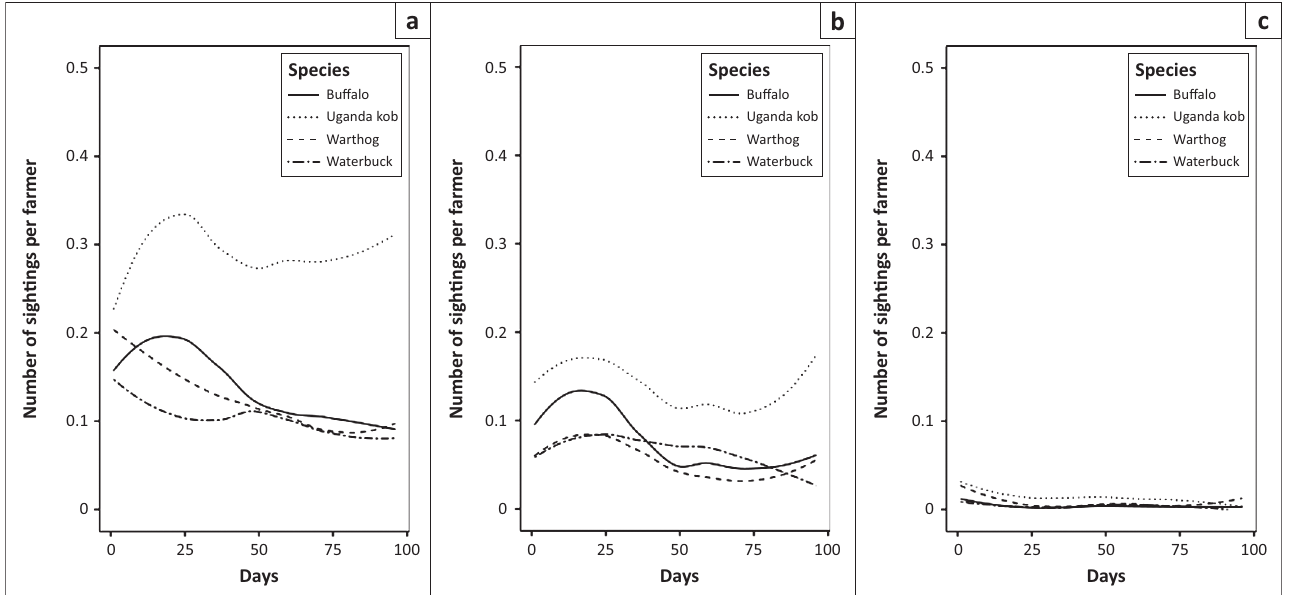
FIGURE 4: Number of sightings per farmer per ungulate type, plotted per day for the period December 2014–March 2015. (a) Grazing area, (b) watering point and (c)